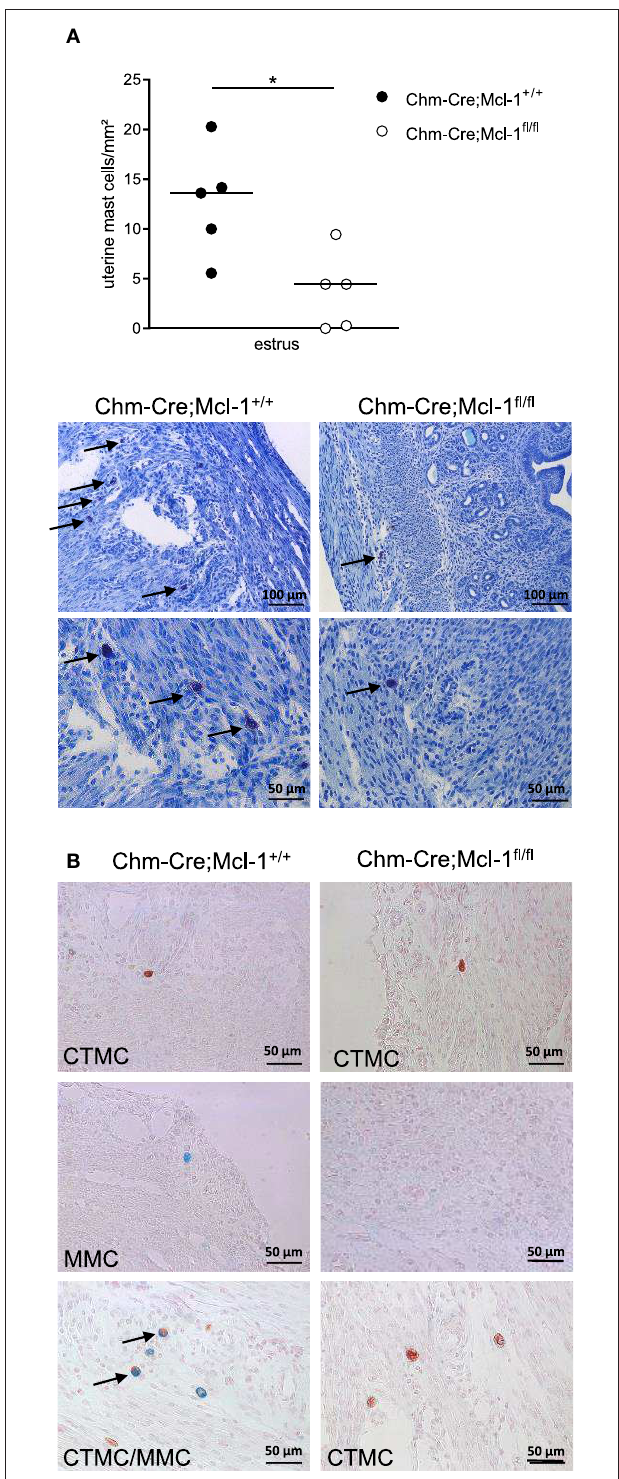
FIGURE 2 | Chm-Cre; Mcl-1 fl / fl mice exhibit reduced numbers of uterus MCs. (A) Toluidine blue staining of 5- µ m-thick paraffin uteri sections showed markedly reduced number of uterus MCs (uMCs) at the estrus cycle (arrows) in Chm-Cre; Mcl-1 fl / fl mice compared to control Chm-Cre; Mcl-1 + / + mice.